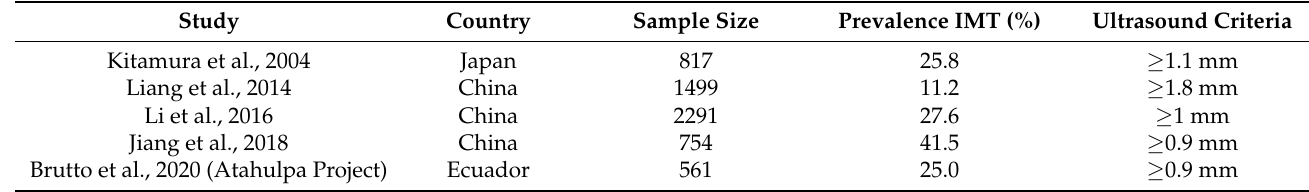
Table 2. Prevalence of increased IMT from retrieved